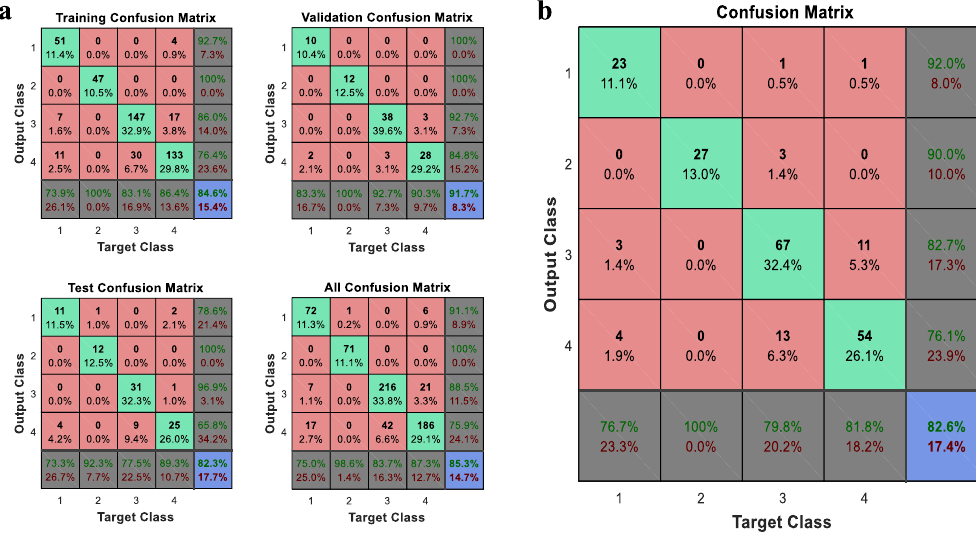
Figure 3. Confusion matrix of 211 Maca training samples ( a ) and 72 test samples ( b ) of four cities. The classes are: 1, Xichang; 2, Dali; 3, Lijing; and 4,